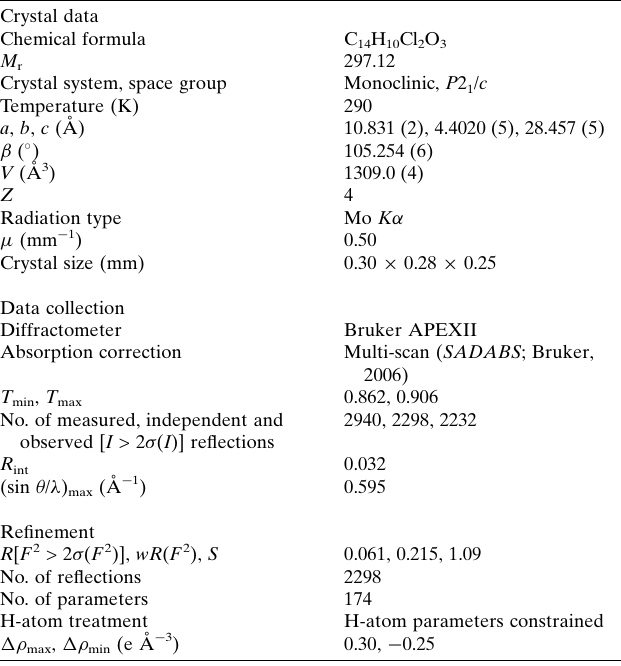
Table 3 Experimental